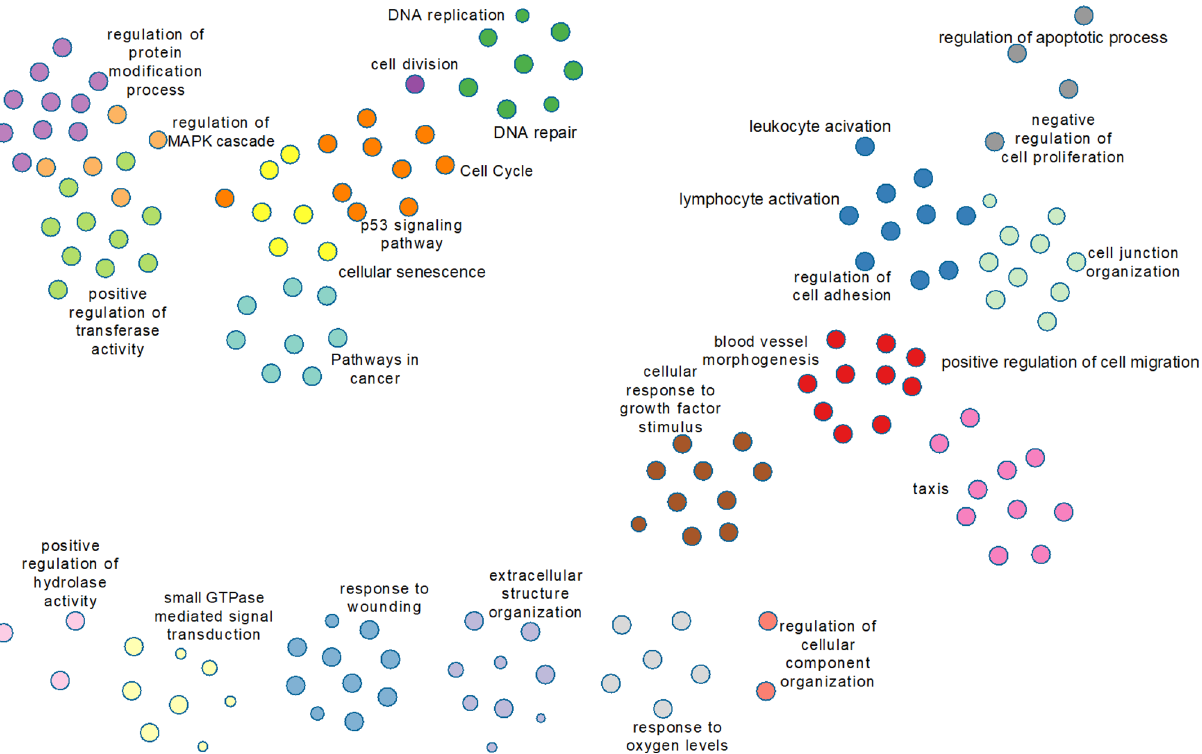
Figure 6. Visualization of clustered GO terms. Metascape (https:// metas cape. org 46 ) was used to create an image of clustered GO terms present in the 1000 genes with the lowest q-value regardless of time point, Clusters, represented by colored circles, are grouped to aid in visualization of the relationships among the 1000 genes with the lowest q-value (q ≤